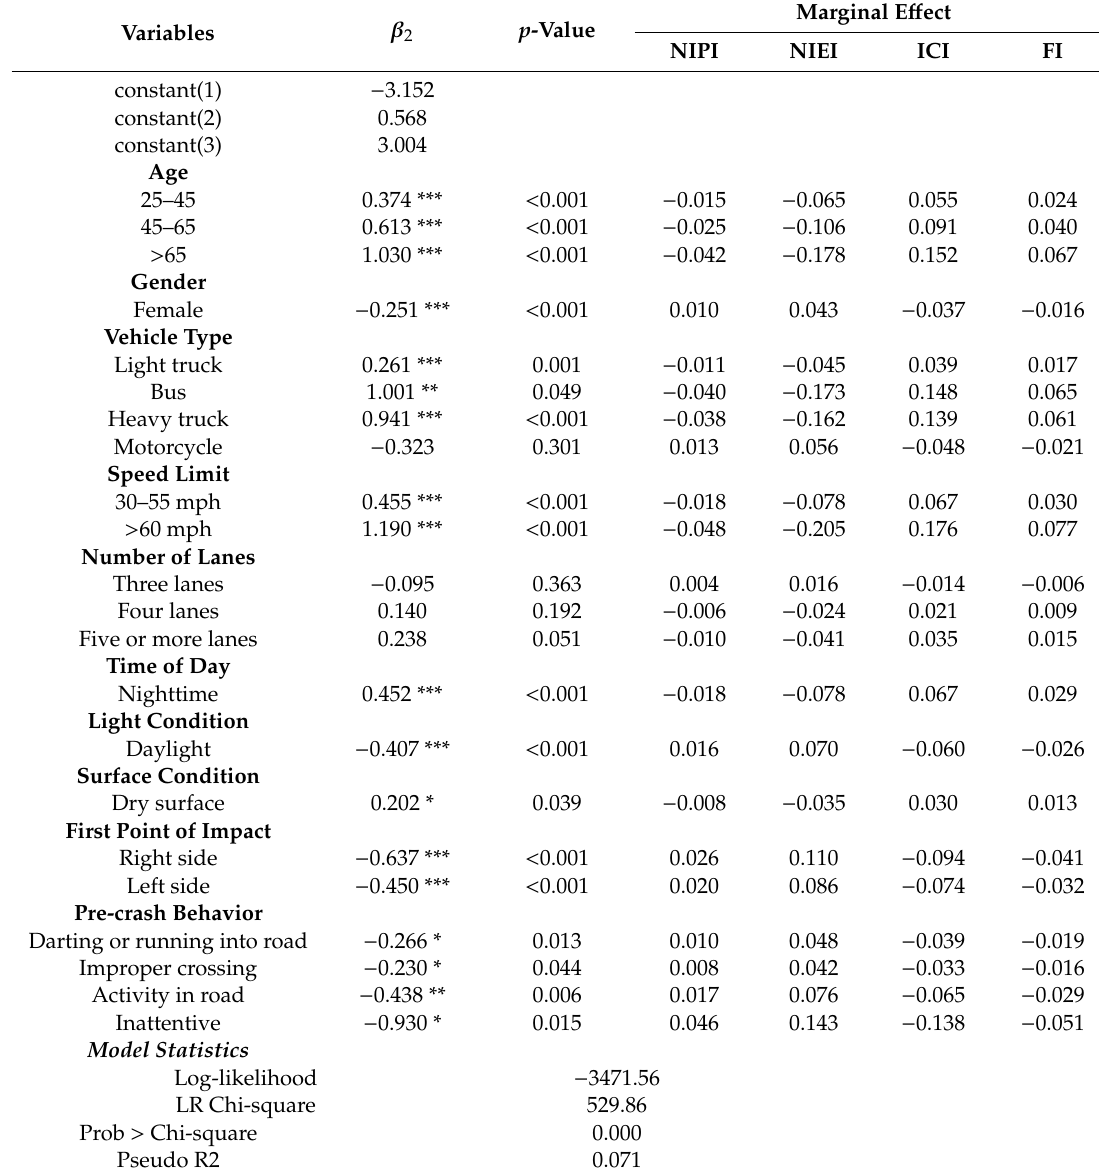
Table 3. Results of the ordered logit model for the pedestrian injury